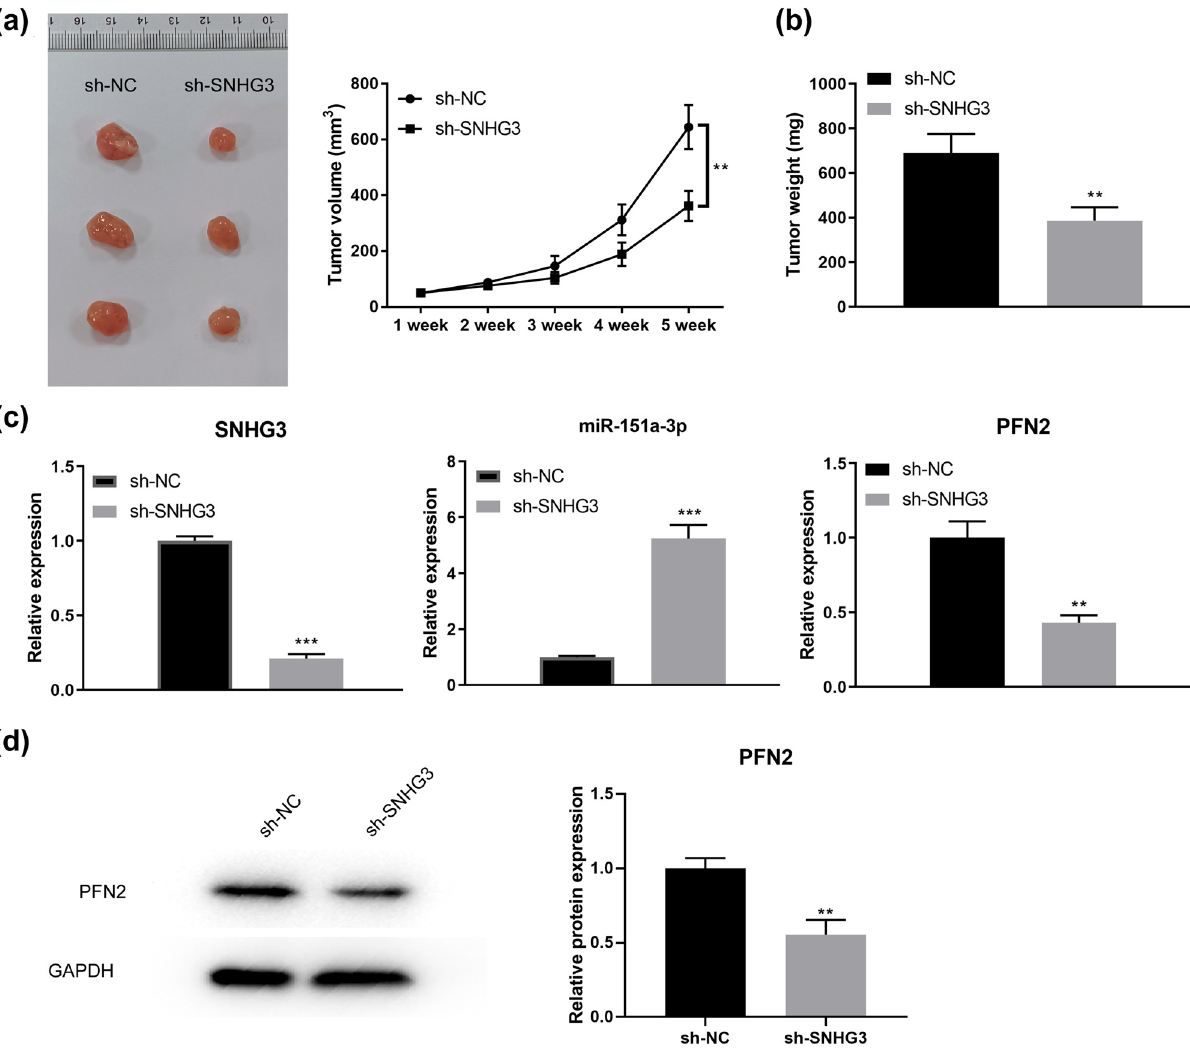
Figure 7: Knockdown of lncRNA SNHG3 suppressed cell growth in vivo. ( a ) Tumor volume was measured every week. ( b ) Tumor weight was examined after 5 weeks. ( c ) The levels of SNHG3, miR - 151a - 3p, and PFN2 mRNA in the collected tumors were detected by qRT - PCR. ( d ) The protein level of PFN2 was measured by western blot. ** P < 0.01, *** P <